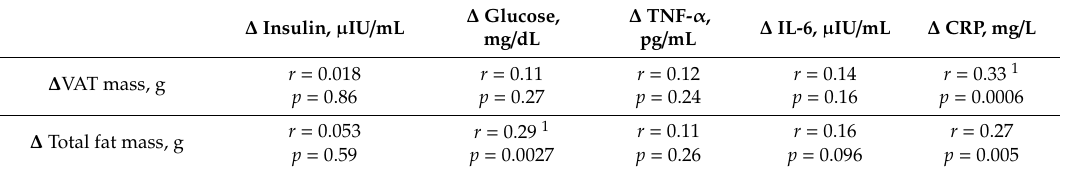
Table 4. Partial Spearman rank correlations for changes in cancer-risk biomarkers with changes in VAT mass and total fat mass, adjusted for change in